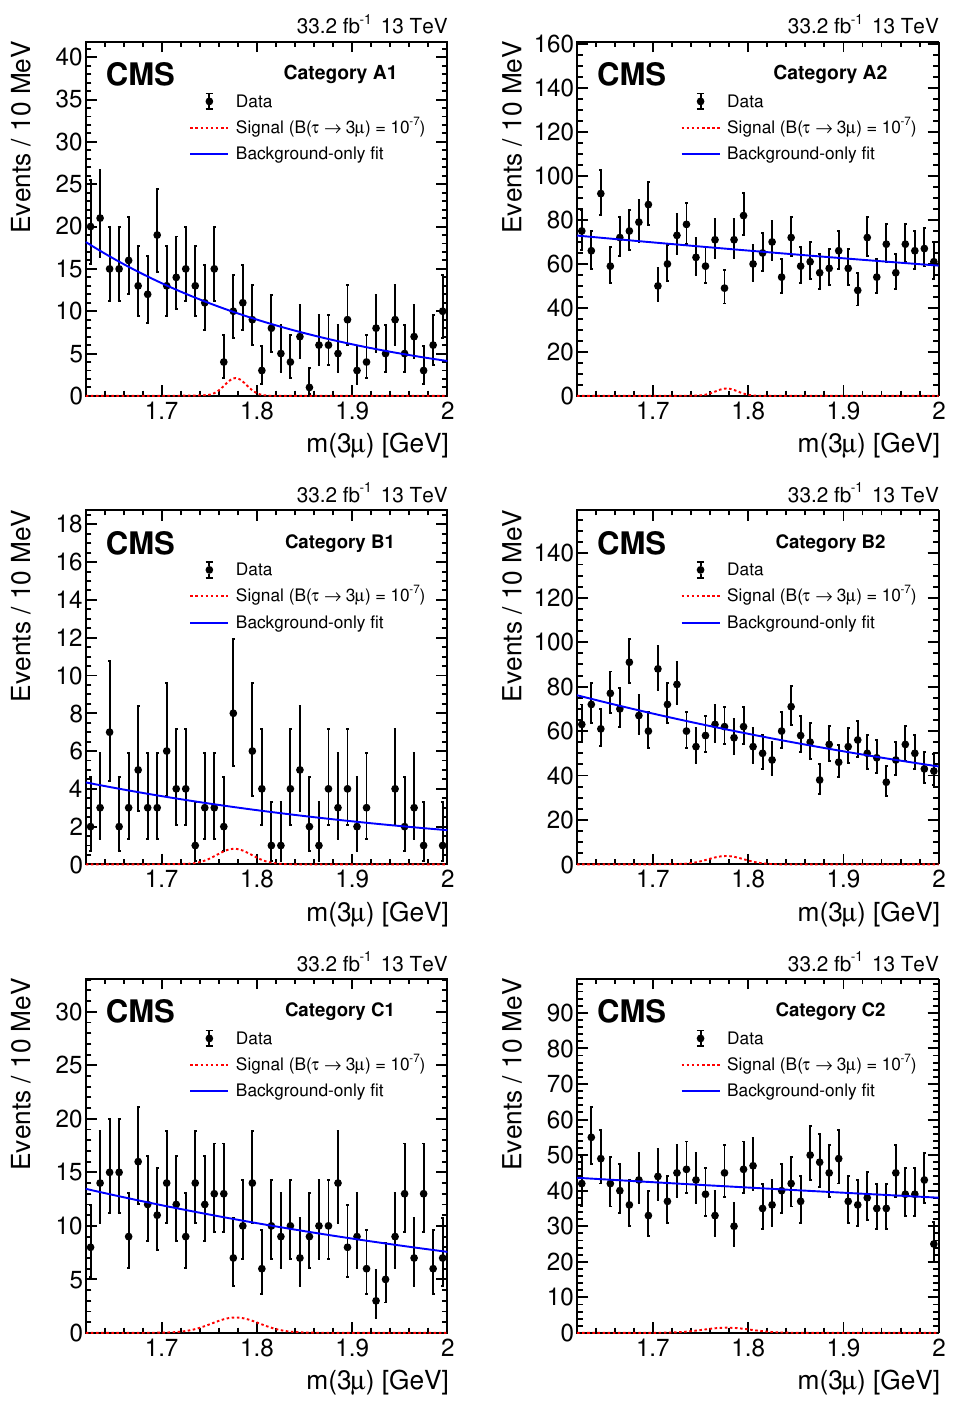
Figure 2 . Trimuon invariant mass distributions in the six independent event categories used in the heavy-flavor analysis and defined in the text: A1, A2, B1, B2, C1, C2. The data are shown with filled circles and vertical bars representing the statistical uncertainty. The background-only fit and the expected signal for B ( t → 3 m ) = 10 − 7 are shown with solid and dashed lines,